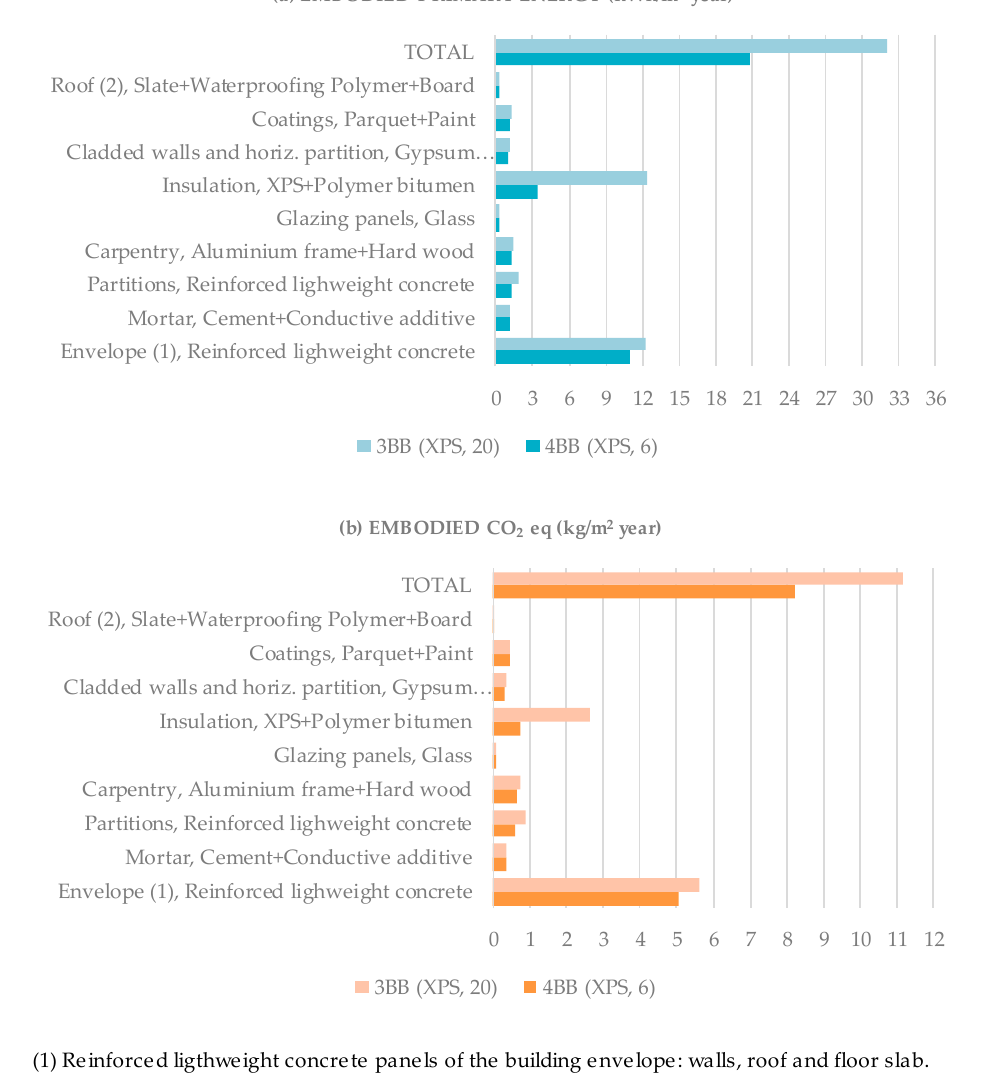
Figure 7. Impacts of the construction elements, by components, per m 2 of usable floor area for 4BB (e XPS = 6 cm) and 3BB (e XPS = 20 cm): ( a ) Embodied energy; ( b ) Equivalent of CO 2 emissions throughout the manufacturing, transport and construction stages.